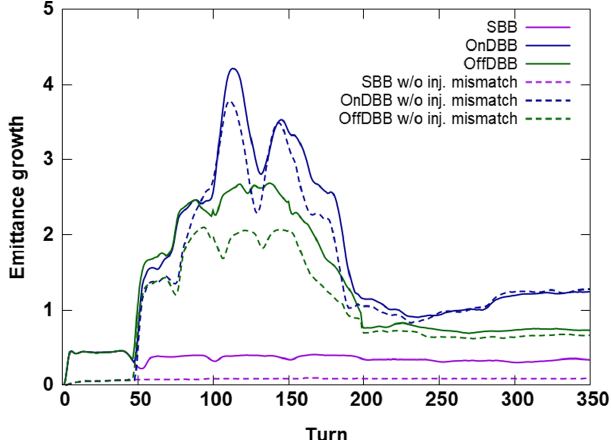
15. Evolution of the longitudinal emittance growths in the SBB, onDBB, and offDBB with (solid lines) and without (dashed lines) injection mismatch.